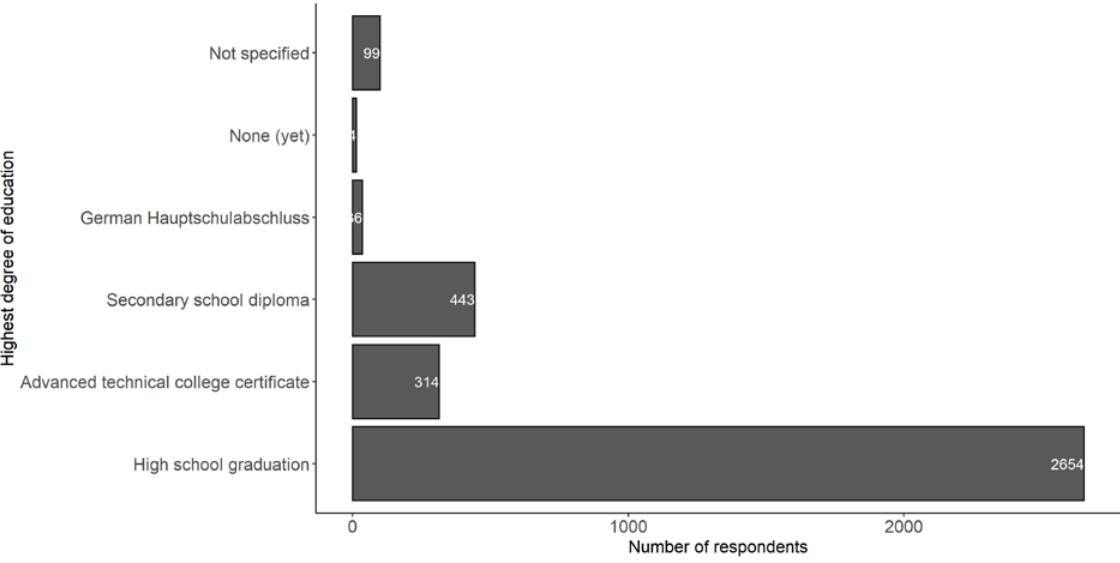
Figure A3.2: Highest educational degree of survey